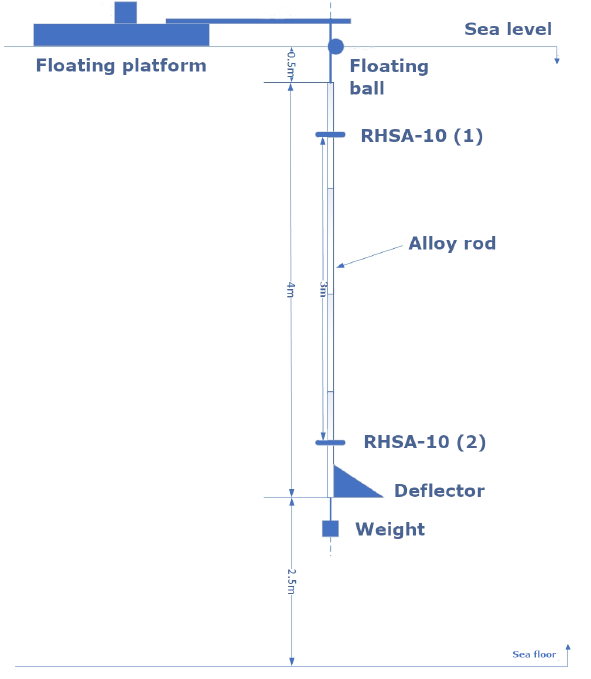
Figure 13. Schematic of hydrophone